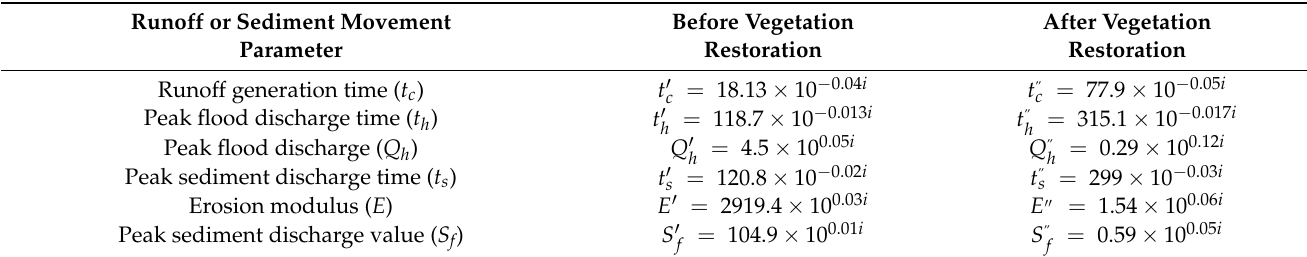
Figure 19. Changes in flow and sediment content after high-level watershed control. Table 4. Parameters of runoff and sediment generation in small watersheds, before and after vegetation restoration.